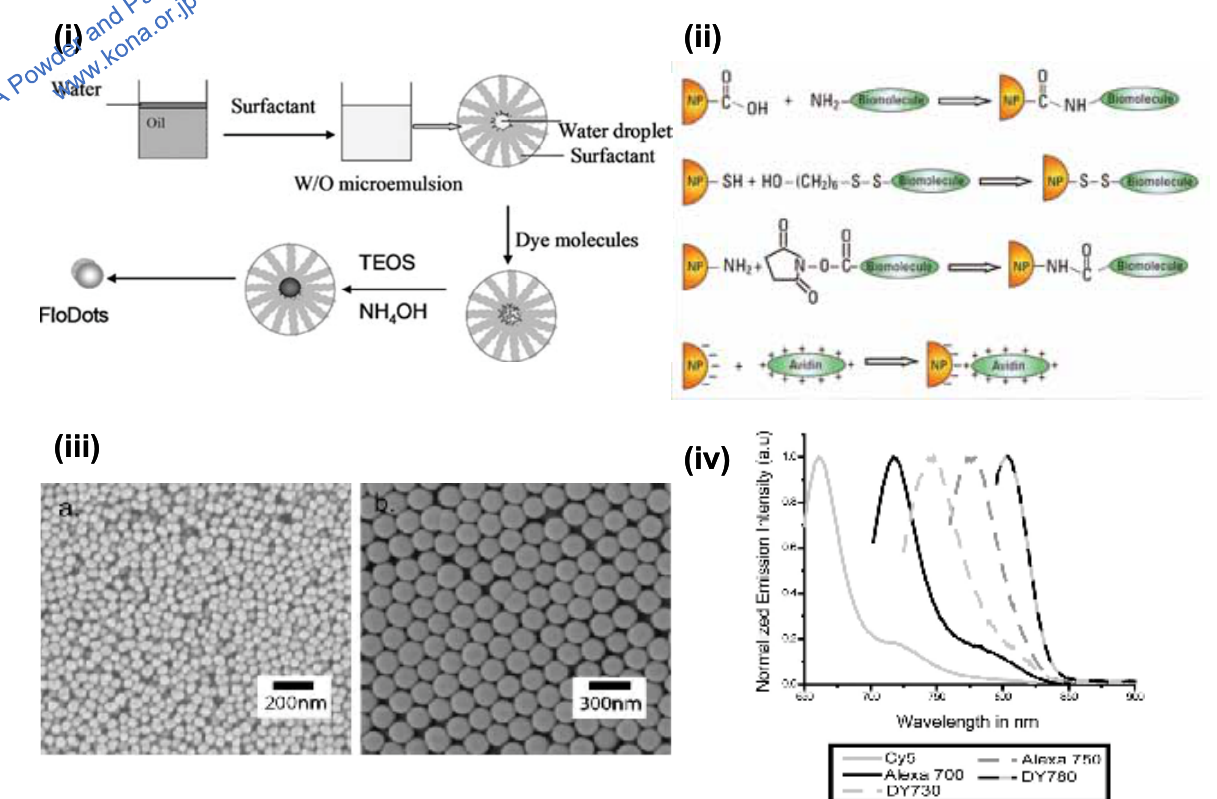
Fig. 1 (i) Schematic representation of microemulsion process commonly used for the synthesis of silica nanoparticles 3 . (ii) surface functionalization methods for silica nanoparticles 4) (iii) TEM images of monodisperse dye doped silica nanoparticles 149) (iv) Typical fluorescence spectra for dye doped silica nanoparticles 150) . （ Reprinted, with permis- sion, from Reference 〔 3, 4, 149, 150